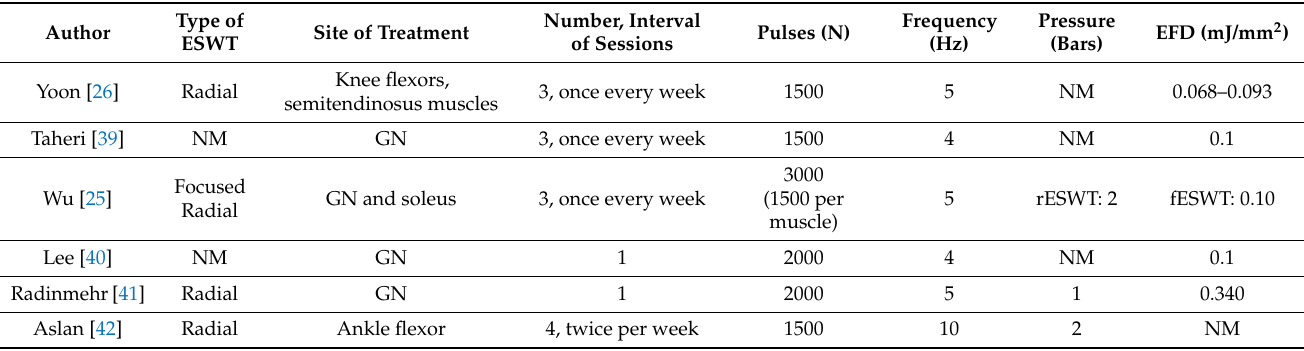
Table 4. Lower limb studies-ESWT